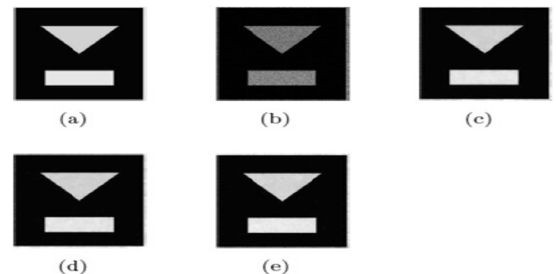
Fig. 8: Reconstructed image By M2 for artificial image Synimage3; (a) True Image (b) Degrade image with L 1 = 0.05; (c) Restored by optimal value c = 180; (d) Restored By c = 1.87; (e) Restored By c =